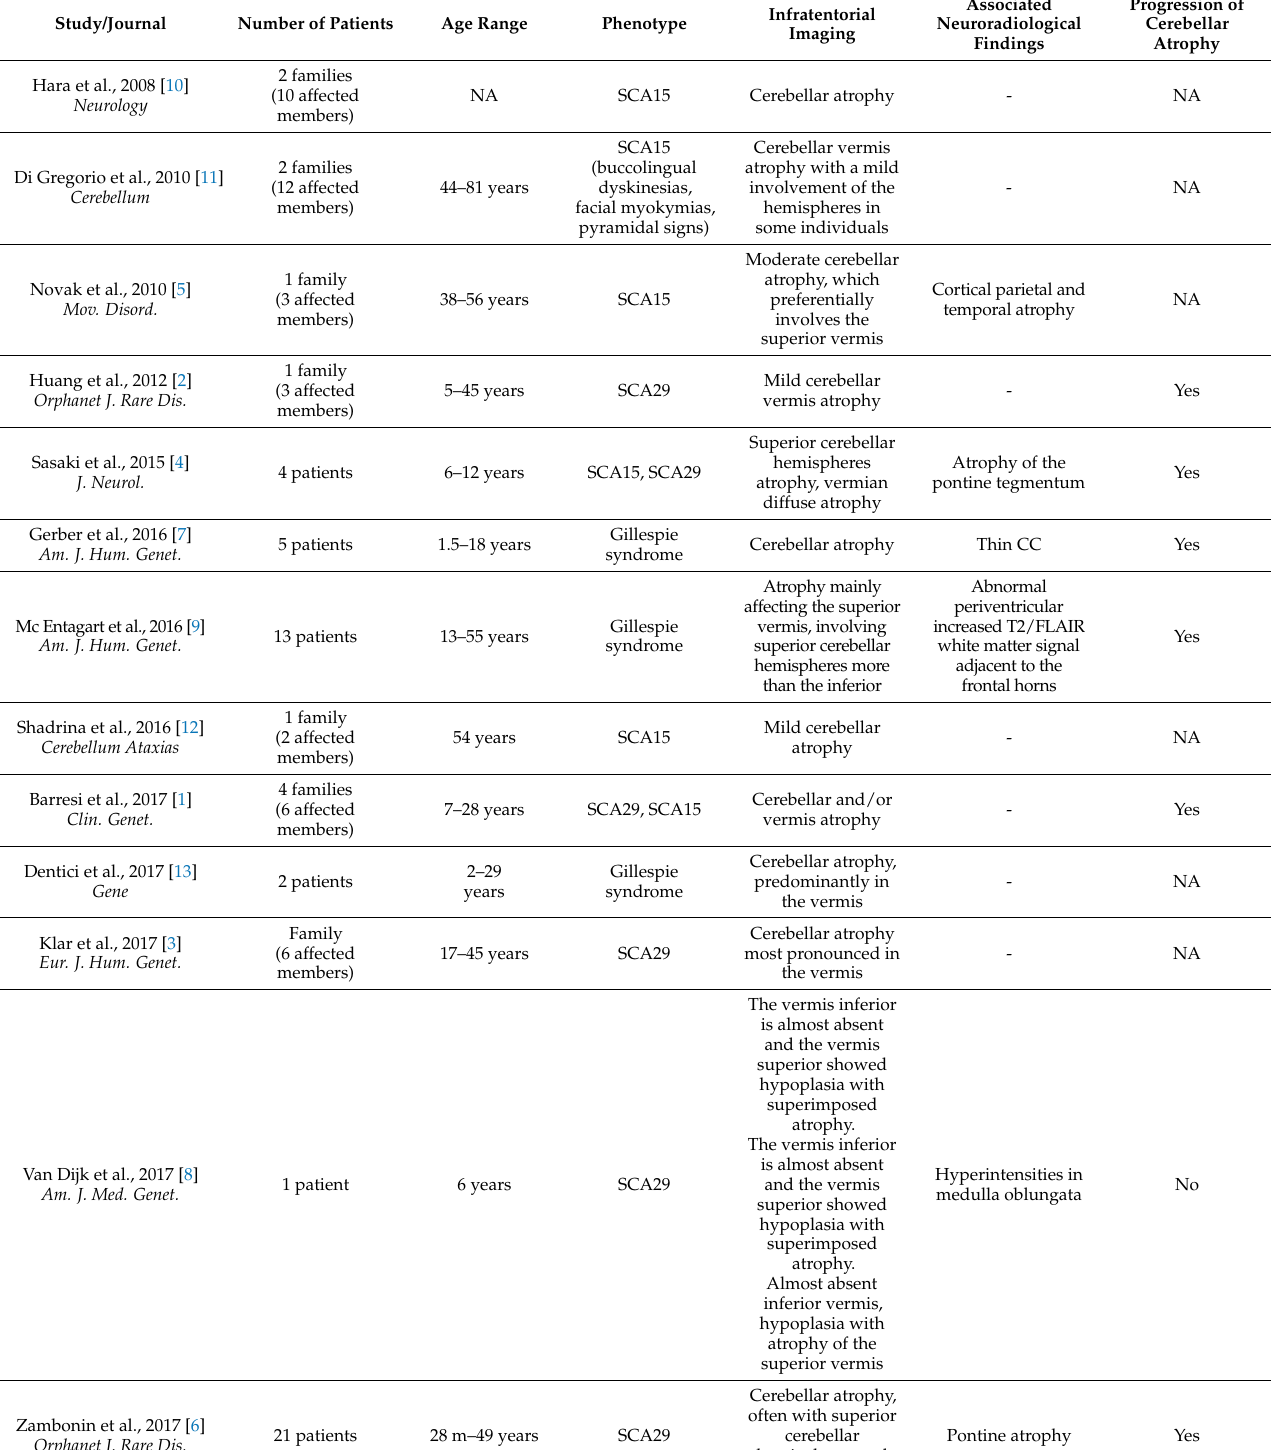
Table 2. Gene mutations described up to